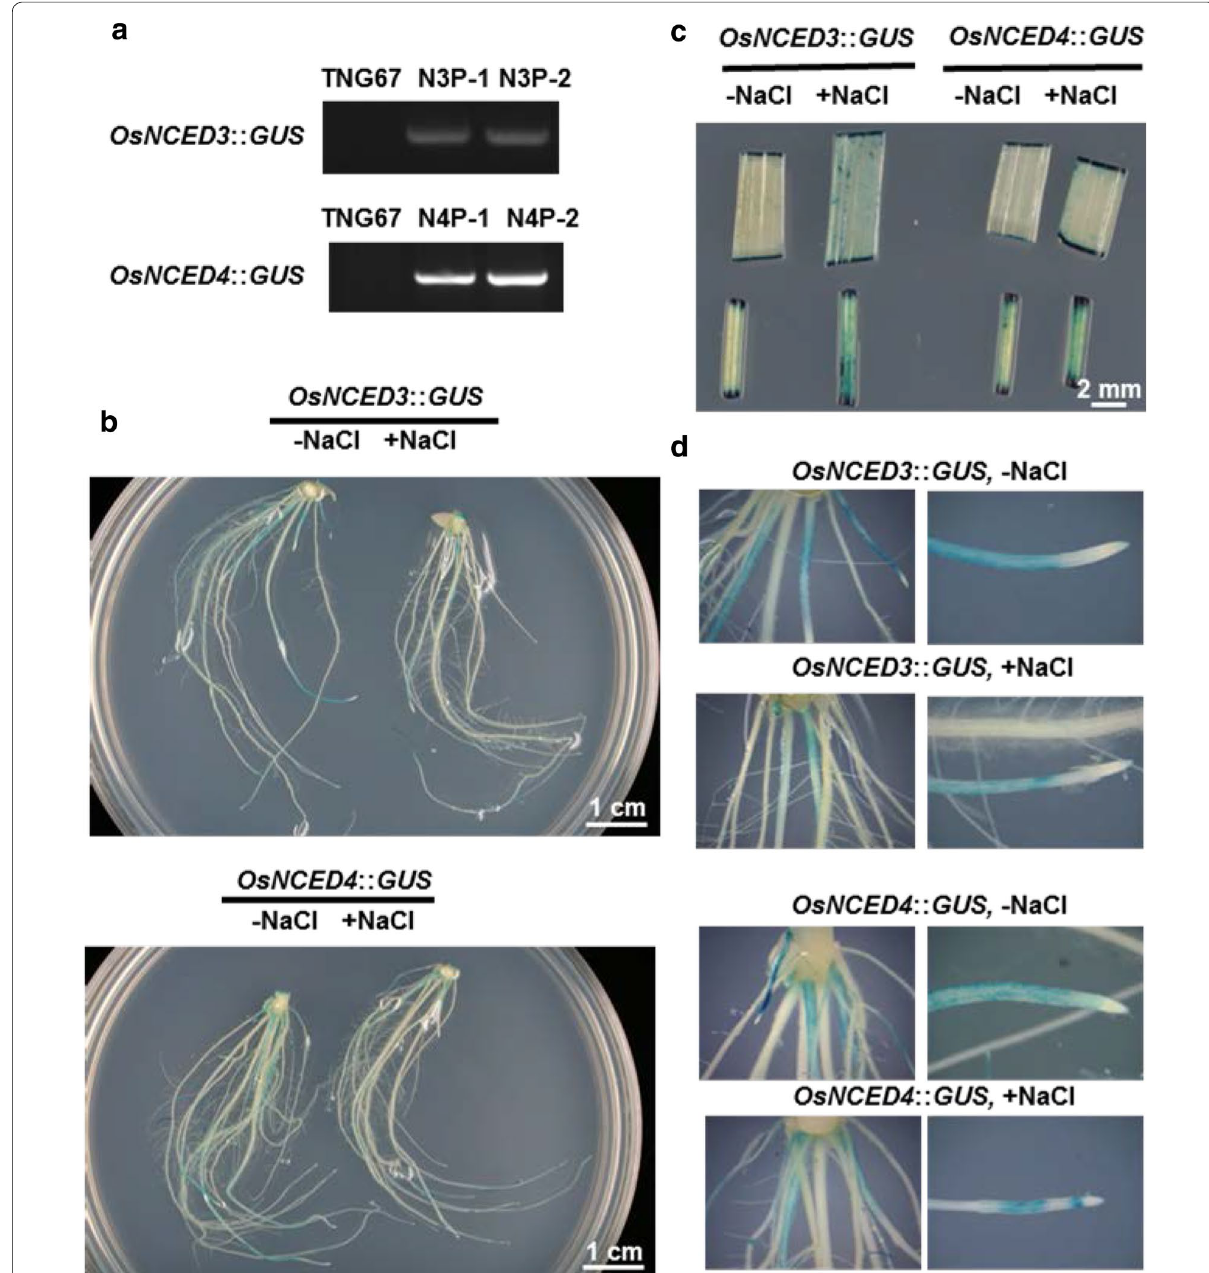
Fig. 8 Comparison of tissue‑specific expression of OsNCED3 and OsNCED4 promoters in transgenic rice plants under salt stress. a PCR analysis of OsNCED3 :: GUS or OsNCED4 :: GUS constructs in N3P or N4P transgenic rice plants, respectively. b GUS staining in roots of 7‑day‑old, solution‑grown transgenic rice seedlings treated with ( NaCl) or without ( NaCl) 150 mM NaCl. c GUS staining in leaf blade and leaf sheath of 7‑day‑old, trans‑ + − genic rice seedlings grown in solution with or without 150 mM NaCl. d GUS staining in root segments of 7‑day‑old transgenic rice seedlings grown in solution with or without 150 mM